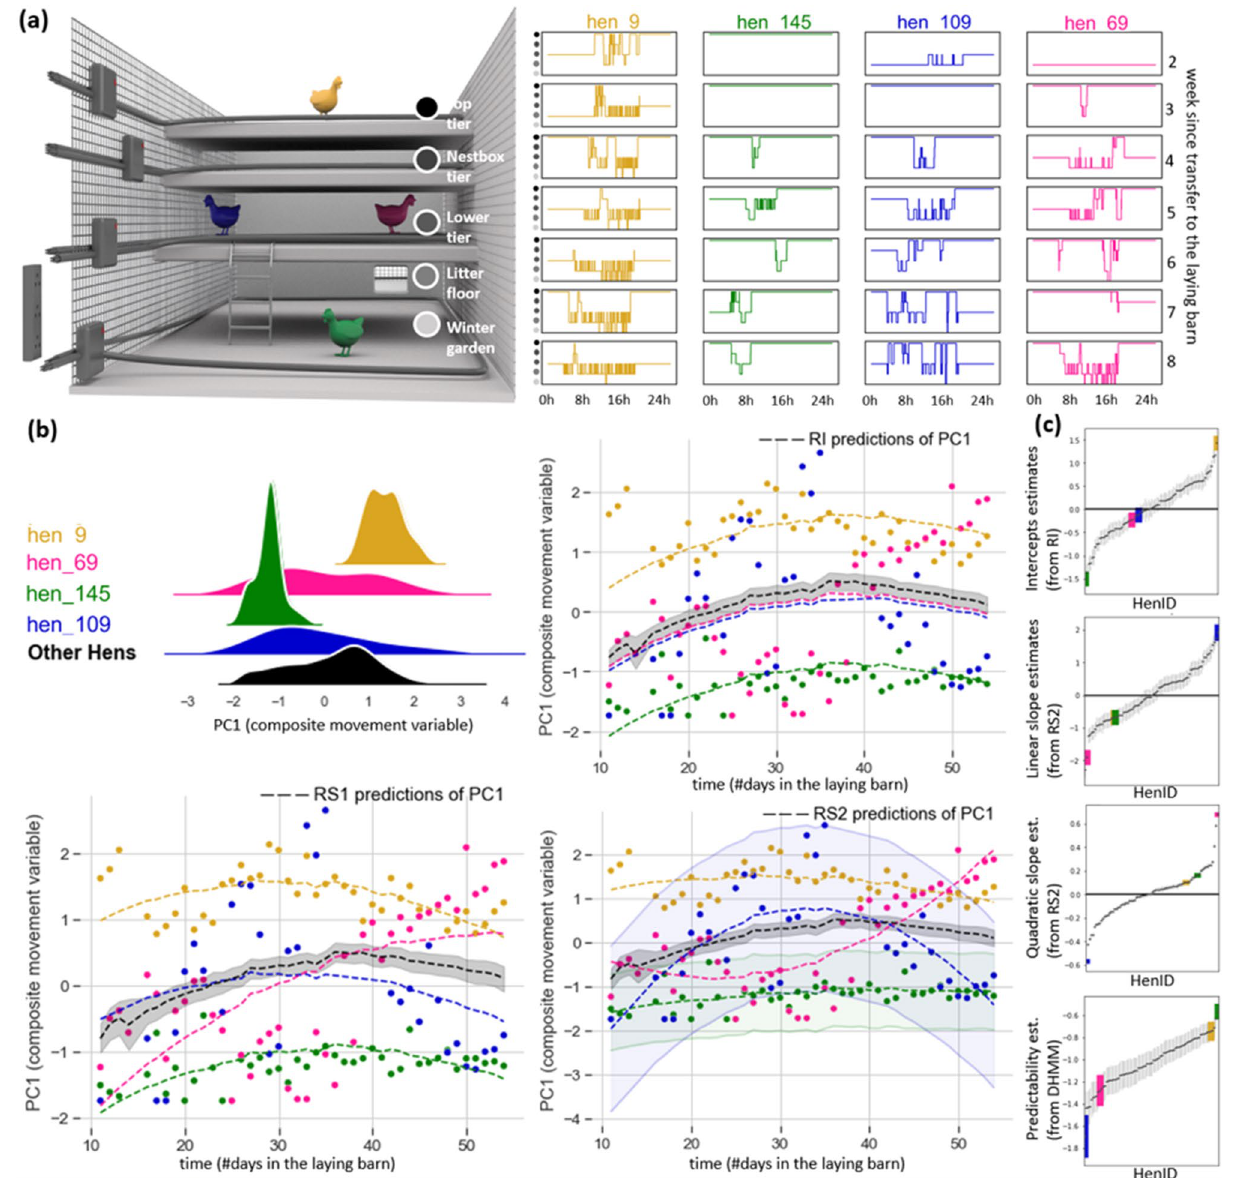
Figure 1. Visual representation of four hens’ transitions across the five aviary zones, daily PC1 scores and individual estimates. Hen 145 and hen 9 have the smallest and largest intercept estimates, respectively. Hen 109 and hen 69 have the smallest and largest quadratic slope estimates, respectively. ( a ) On the left side we showed a simplified representation of the laying barn and the tracking system equipment (dark grey) and on the right side we showed seven (one per week) daily time series of the hens’ transitions across the five aviary zones. Each column represents one hen and each row represents the first tracked day of a particular week. ( b ) PC1 daily scores of four hens including a kernel density estimate (top left); the daily PC1 score over time (dots); the PC1 predictions from studied models (dashed lines); shaded areas around the prediction of two hens to illustrate predictability estimates (represented by a constant value = max estimates (mean ± sd) of studied hens (intercept, linear slope, quadratic slope, and predictability) sorted by the smallest to the highest estimates. Welfare